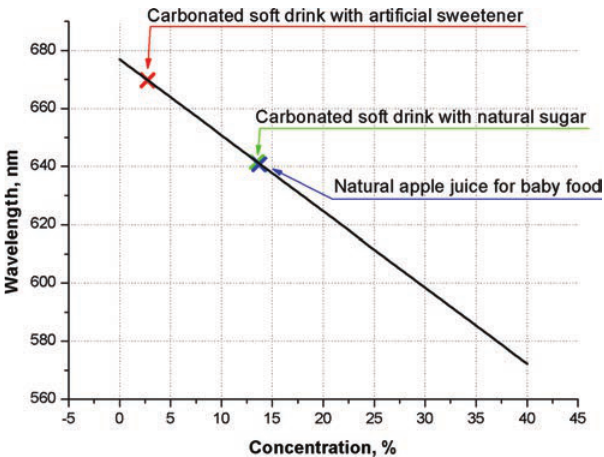
Fig. 7. Dependence for shift of transmission maximum of PCW ¯lled up with glucose solution on its concentration (solid line, calibration) and experimental data for three samples of soft drinks.